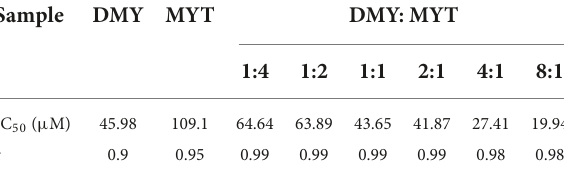
FIGURE3 Inhibitory effect of different kinds of vine tea extracts on the proliferation of B16F10 cells. Values are means ± SD ( n = 3). B16F10 cells were treated for 24 h with inhibitor (10 µ g/mL VTEs of different varieties) and medium (control), and cell viability was determined using the MTT assay. Different letters and capitalization indicate significant differences between means at P < 0.05 by one-way ANOVA followed by Duncan comparison test. (A) Wild vine tea in Enshi, Hubei. (B) Hubei Enshi selenium-rich vine tea. (C) Guangzhou Qingyuan (Level 1). (D) Guangzhou Qingyuan (Level 2). (E) Wild vine tea in Shiqian,